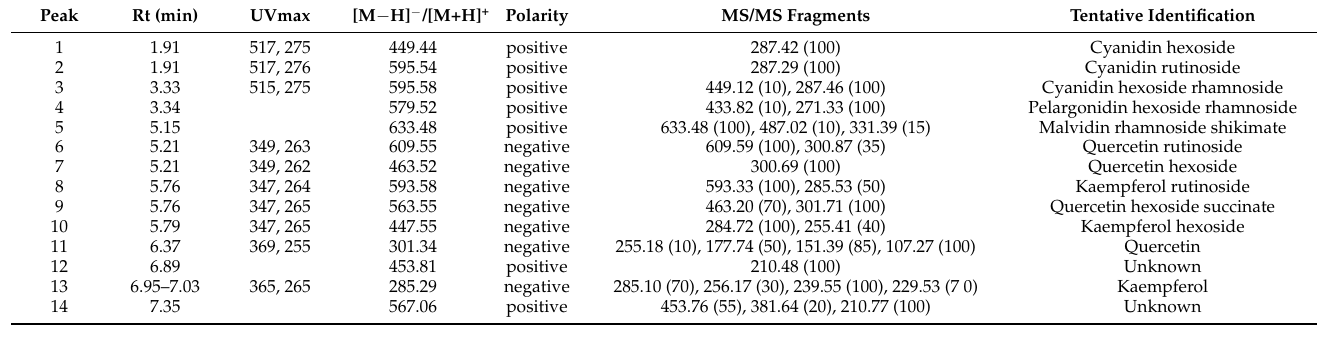
Table 7. Tentative identification of the main components occurring in the edible fruits kurugua ( S. odorifera ) through UPLC-ESI-MS/MS.